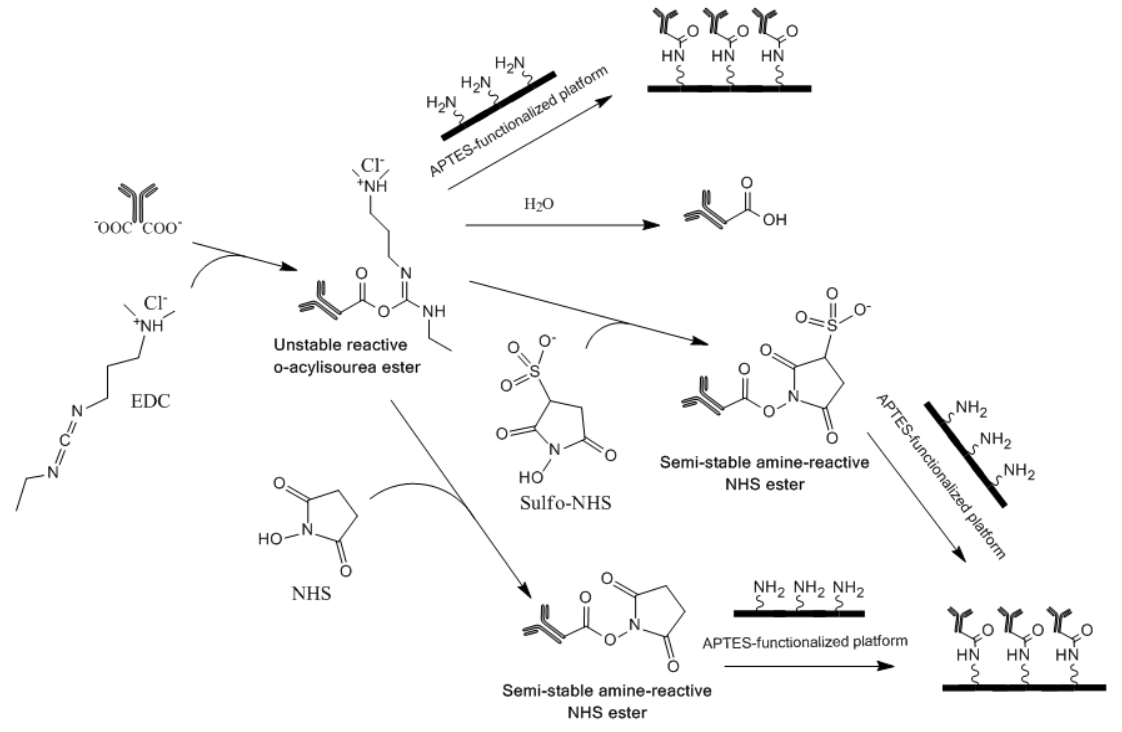
Figure 1. Schematic for the various 1-Ethyl-3-(3-dimethylaminopropyl) carbodiimide (EDC)-based chemistries that were employed to crosslink antibodies to antibodies on 3-aminopropyltriethoxysilane (APTES)-functionalized platforms for immunodiagnostic